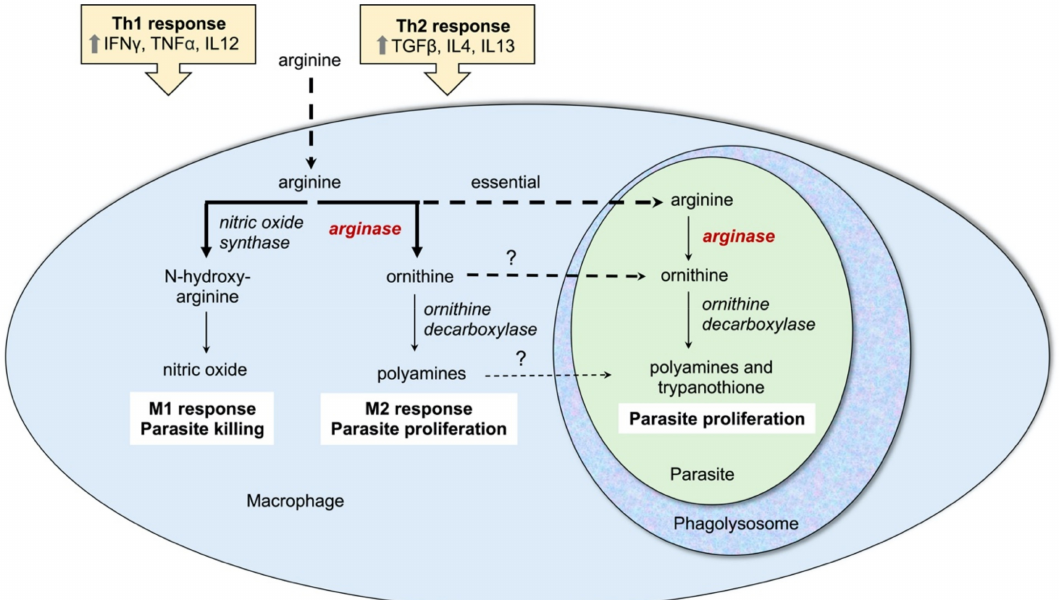
Figure 3. Interplay between host and parasite arginase influence disease outcome. The macrophage, phagolysosome, and intracellular parasite are shown. Indicated in yellow boxes are the opposing Th1 and Th2 responses with associated cytokine production. White boxes denote macrophage polarization towards an M1 or M2 phenotype with resulting parasite killing or proliferation. The conversion of arginine to nitric oxide or polyamines in the macrophage is shown with solid arrows, as is the conversion of arginine to polyamines and trypanothione in the intracellular parasite. Uptake of arginine, ornithine, or polyamines is shown in hashed arrows. The essential uptake of arginine by parasites is indicated; the question marks denote that ornithine and polyamine salvage has not been directly demonstrated in intracellular